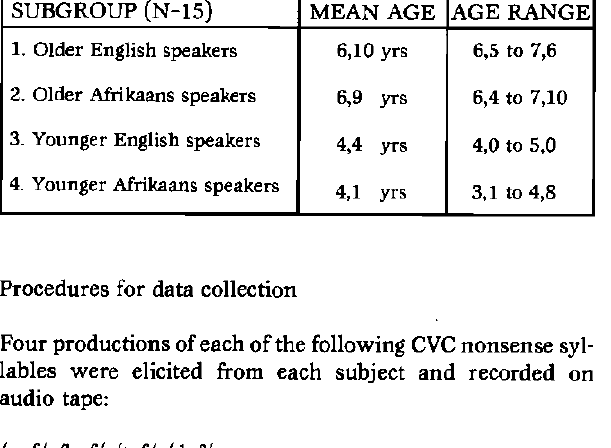
Table 1: Subject groupings with mean ages in years and months SUBGROUP